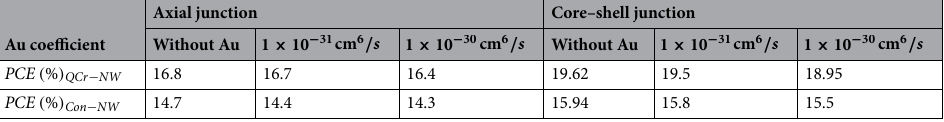
Table 5. The PCE of the proposed and conventional NW designs in the axial and core–shell junction with and without AR mechanism.